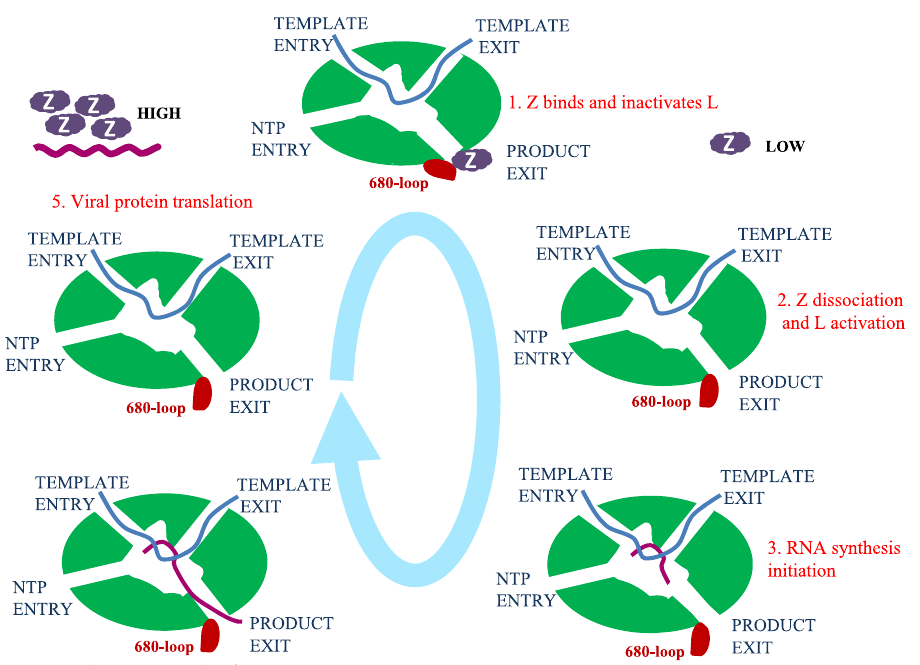
Fig. 6 The proposed model of JUNV L regulation by Z during the viral life cycle and RNA synthesis. The interaction and regulation of JUNV Z with L was divided into fi ve separate steps, including: (1) Viral entry bringing inactivated L in RNP complex, (2) Z dissociation and L activation at low concentration of Z, 3) RNA synthesis initiation and elongation, (4) Nascent RNA ’ s exit from L, (5) Z synthesized at late stage binds and locks L in inactivated state for virion